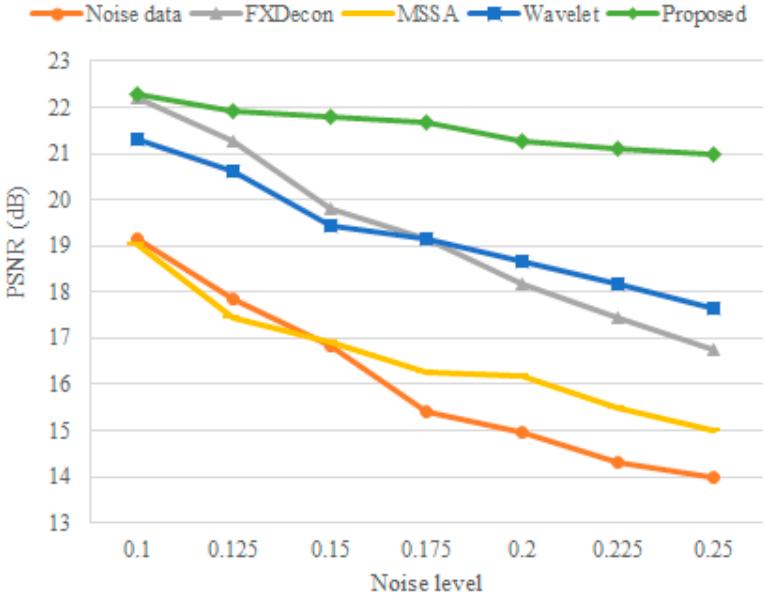
Figure 10. Denoising PSNR values at different random noise levels. The red line represents the PSNR of the noise signal, and the grey, yellow, blue, and green lines represent the PSNR denoising results by FXDECON, MSSA, wavelet transform, and the proposed method, respectively.